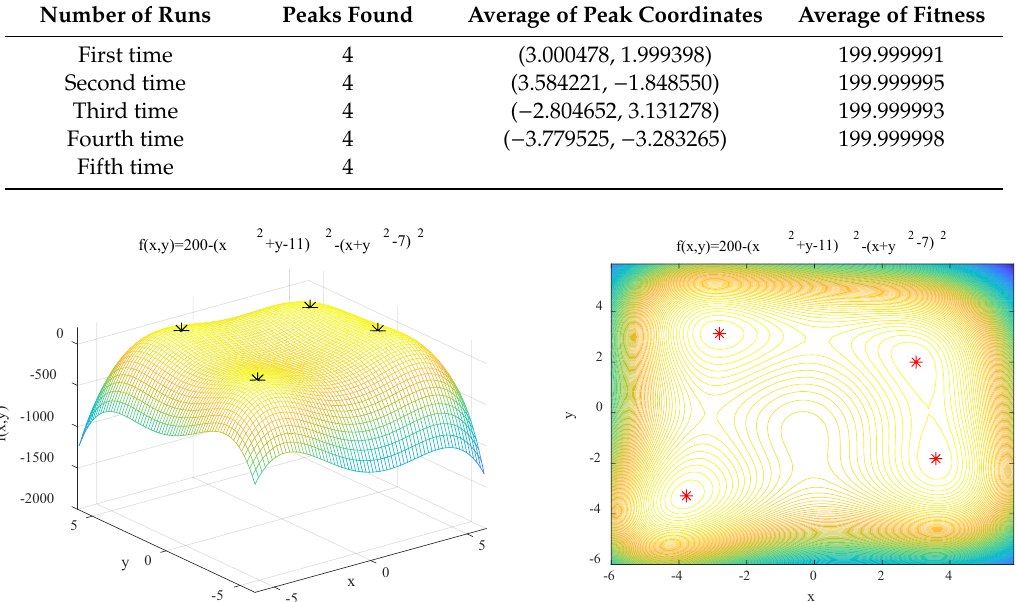
Figure 9. Results of performing IAFSA once to find the peaks of f 3.